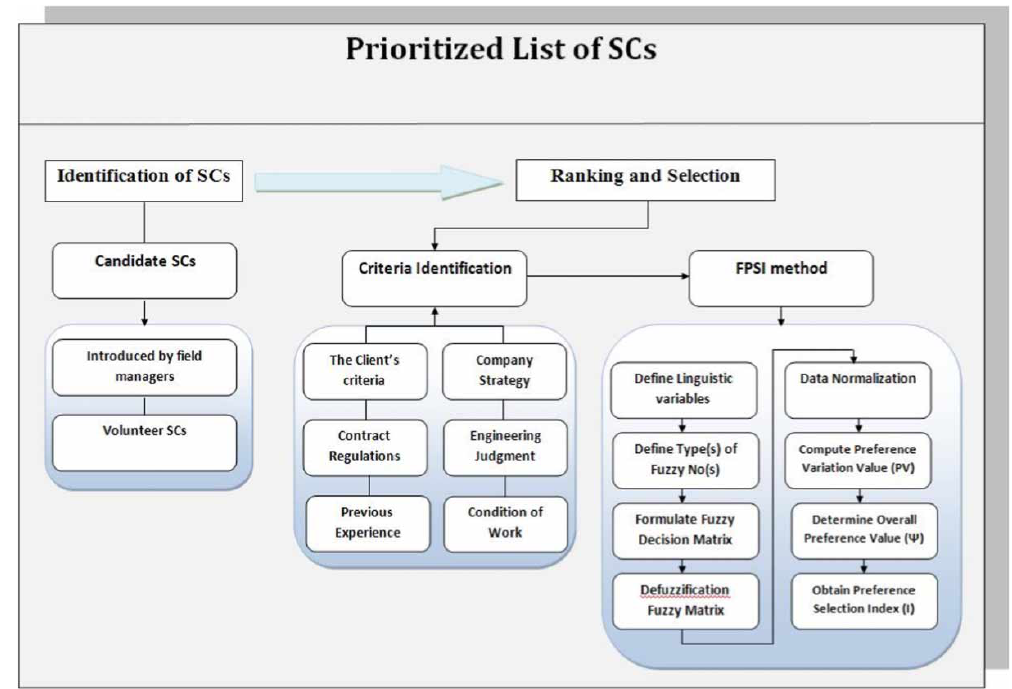
Fig. 1. A SC selection